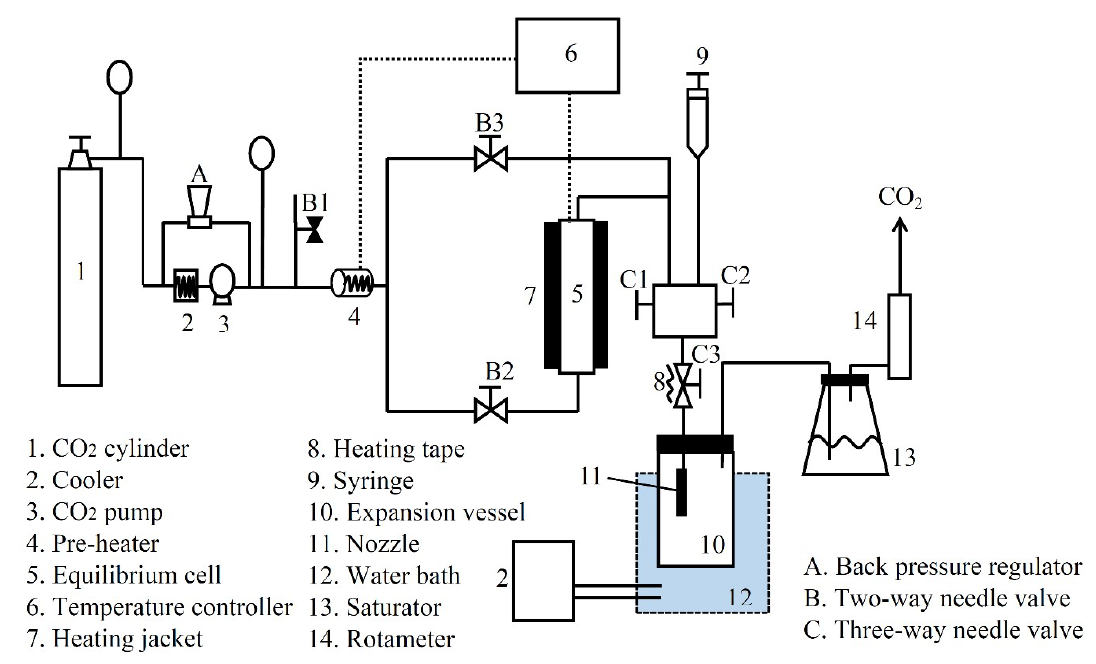
Figure 2. Schematic diagram of the experimental apparatus used for the RESS process.